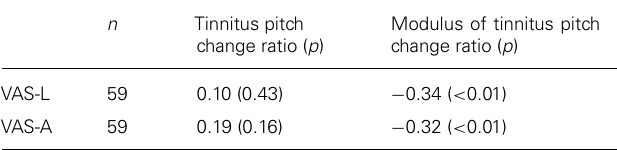
Table 3 | Correlation ( p value) between change inVAS-L,VAS-A, and tinnitus pitch change